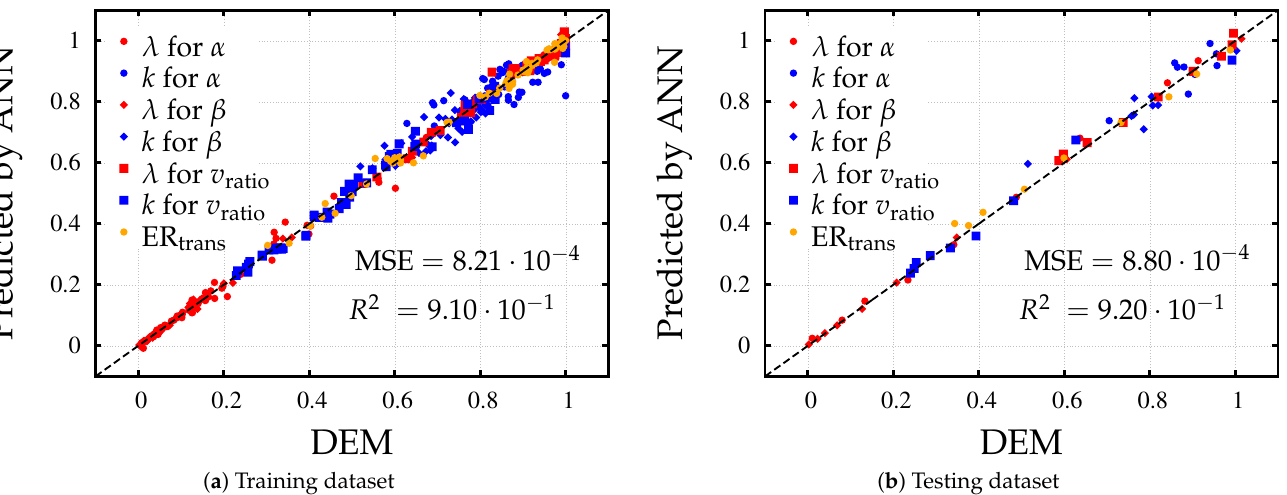
Figure 4. Normalized ANN predictions vs. normalized DEM results concerning the shape k and the scale λ parameters of the Weibull distributions and the kinetic energy ratio ER trans for ( a ) the training dataset and ( b ) the testing dataset. The number of data points for each output quantity in the training and the testing dataset is about 58 and 9, respectively. The reference line is dashed and has a slope of